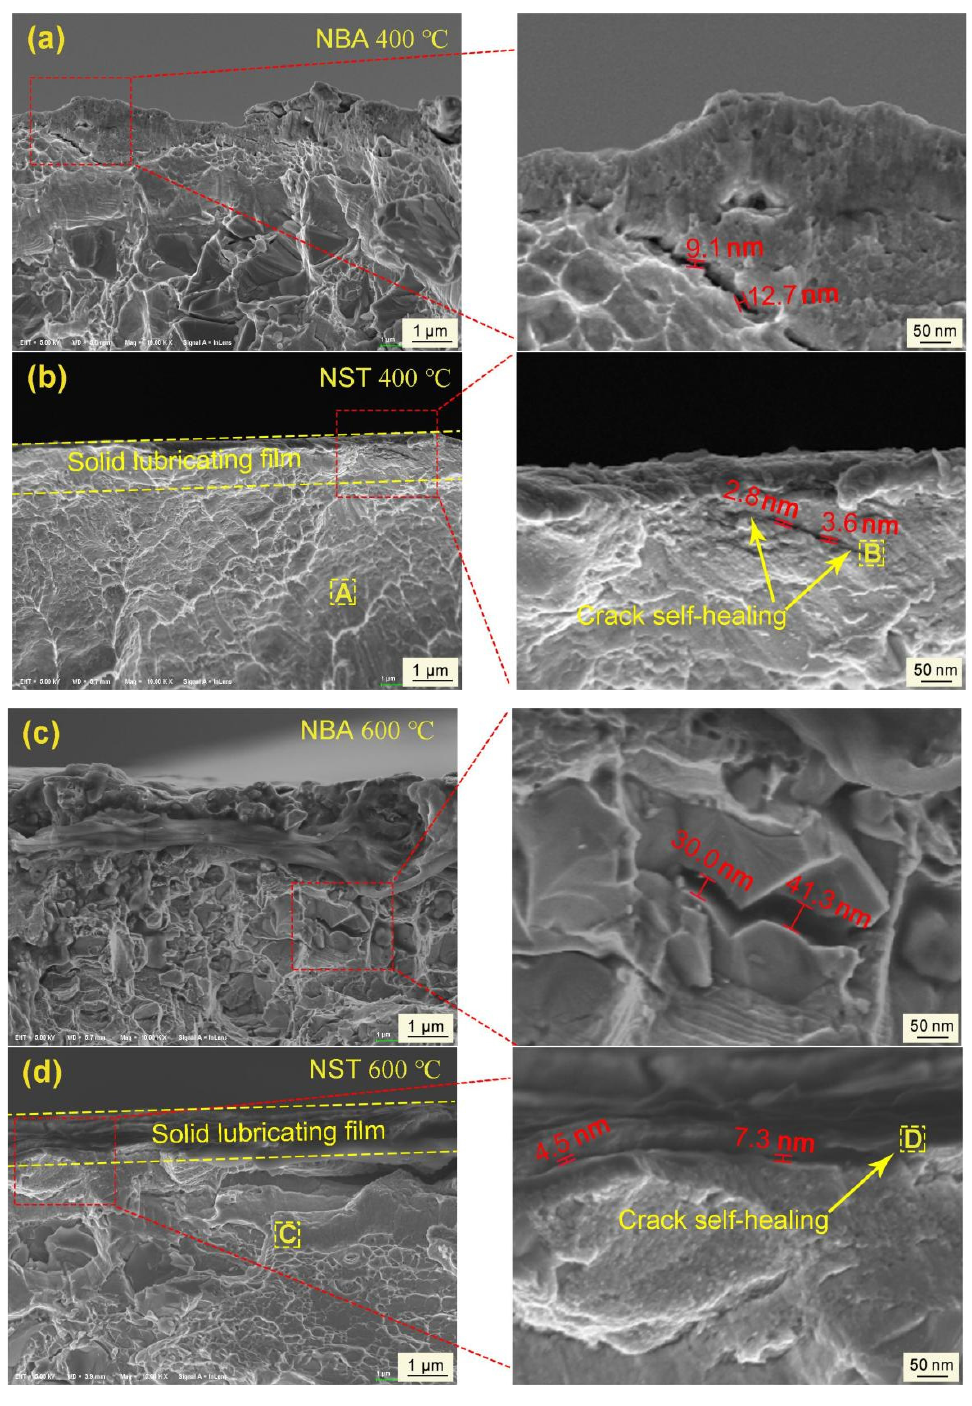
Figure 13. Representative morphologies of cross-sections of NBA ( a , c ) and NST ( b , d ) at 400 and 600 °C. Table 5. Average values of crack widths on the cross-sections of NBA and NST and crack recovery ratio of NST relative to